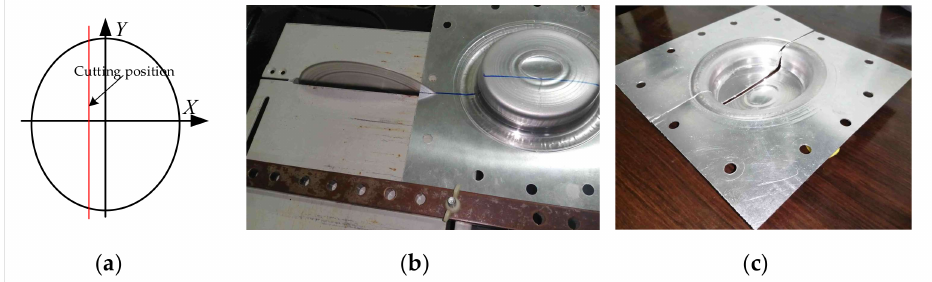
Figure 32. Cutting: ( a ) the cutting position; ( b ) the cutting process; ( c ) the experimental part after cutting.